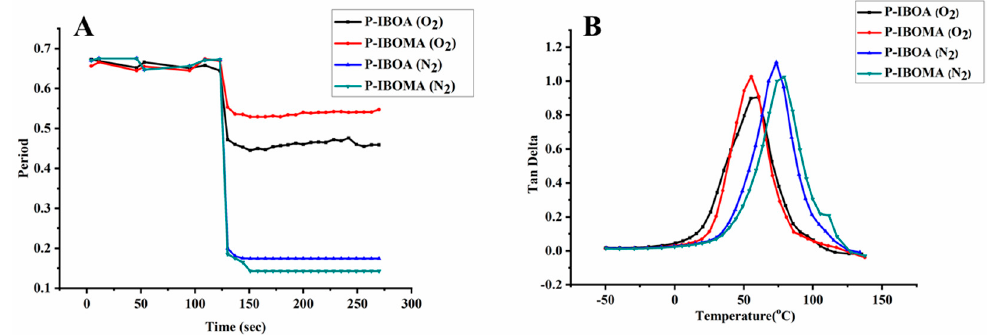
Figure 13. ( A ) Curing behavior and ( B ) Tan δ values of UV-curable PUA coating films in the O 2 and in N 2 atmosphere.